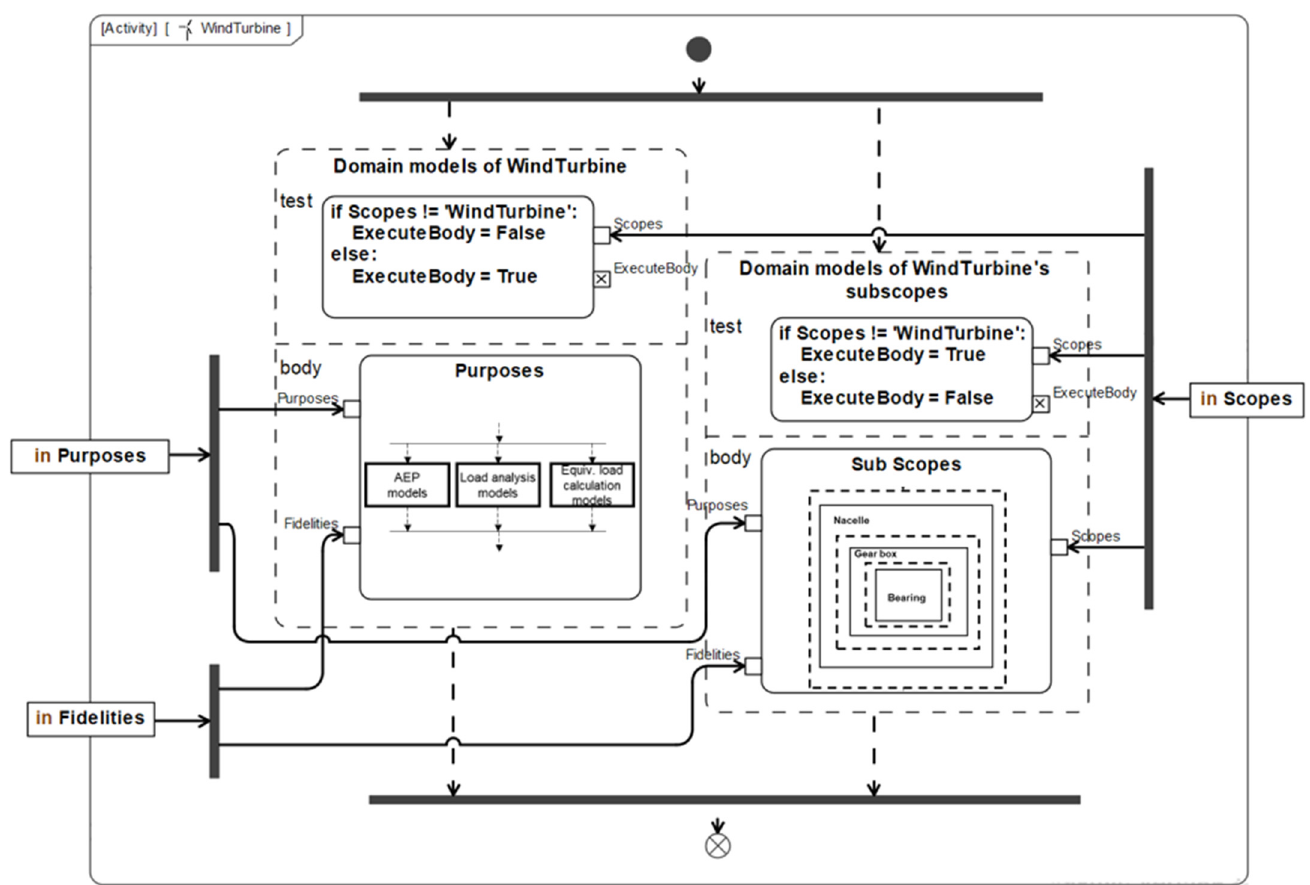
Figure 10. Determination of the system scope of the domain model automatically based on conditional node activities.